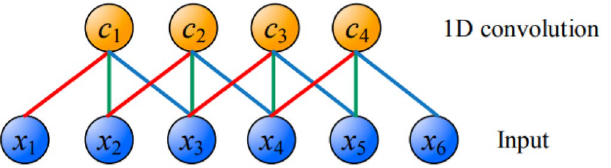
Figure 2. The 1-dimensional convolution operation. Symbol as per “Theoretical overview”